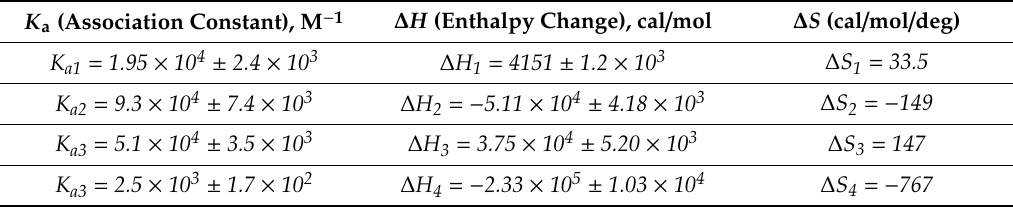
Figure 6. Isothermal titration calorimetric measurement of hordenine titration with PDK3. (Top) Raw data plot of heat produced against time for the titration of 500 µ M hordenine into 15 µ M PDK3. The lower panel shows the binding isotherm obtained after the integration of peak area and normalization to yield a plot of molar enthalpy change against the hordenine / PDK3 ratio. The fit curve is shown in the red color line obtained after four model sites.